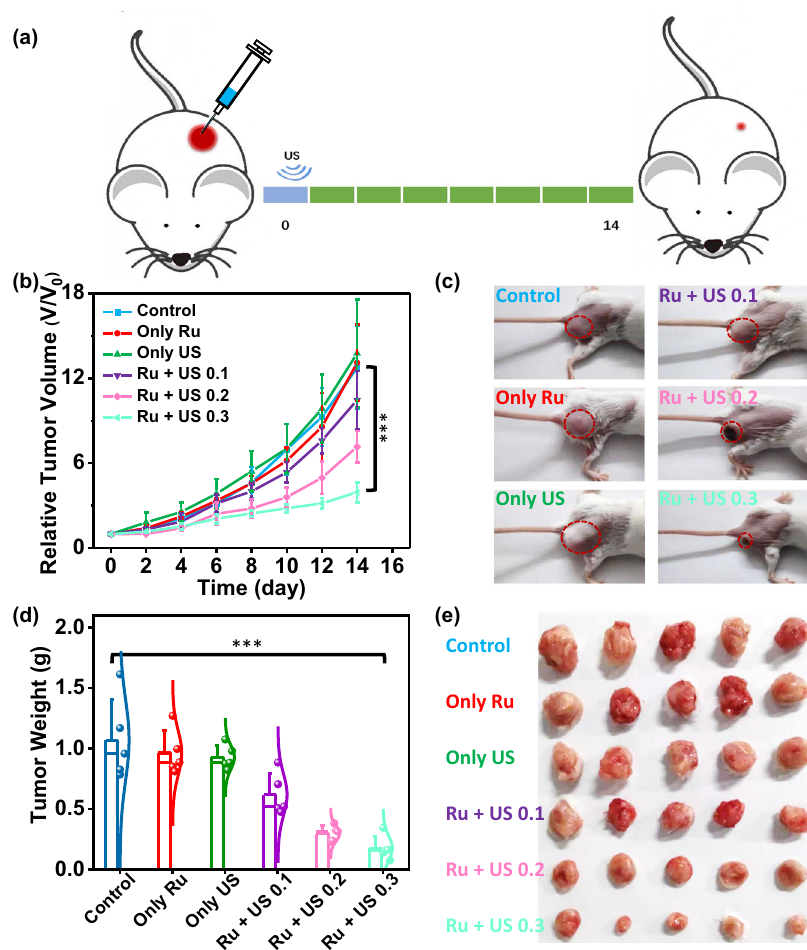
Fig. 5 In vivo sonotherapy. a Schematic of the in vivo sonotherapy procedure in 4T1 tumor-bearing mice. Mice was irradiated by US (0.1, 0.2, 0.3 W cm − 2 , 3 MHz) for 20 min after 4 h i.t. injected with [Ru(bpy) 3 ] 2 + solution. Tumor sizes were monitored every two days for 14 days in total. b Tumor growth curves of mice after various treatments. Error bars were standard errors (±SD) based on fi ve mice in each group. Statistical signi fi cance was calculated with two-tailed Student ’ s t test, p = 0.000092 (*** p < 0.001, ** p < 0.01, or * p < 0.05). c Representative images of mice at day 14 after various treatments. d Average tumor weights of mice at 14 day post various treatments as shown in ( e ). e Photos of tumors were collected from mice at 14 day after various treatments. Ru: [Ru(bpy) 3 ] 2 + . Error bars were standard errors based on fi ve mice in each group. Statistical signi fi cance was calculated with